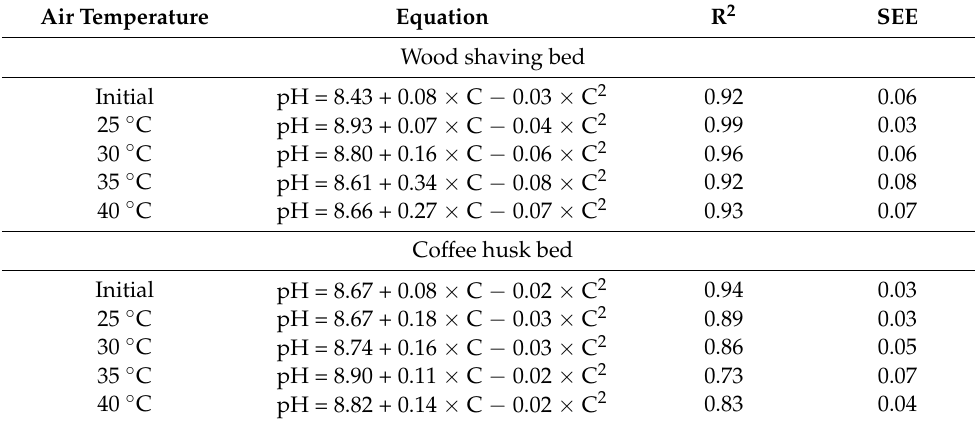
Table 2. Equations adjusted for pH determination of wood shaving and coffee husk